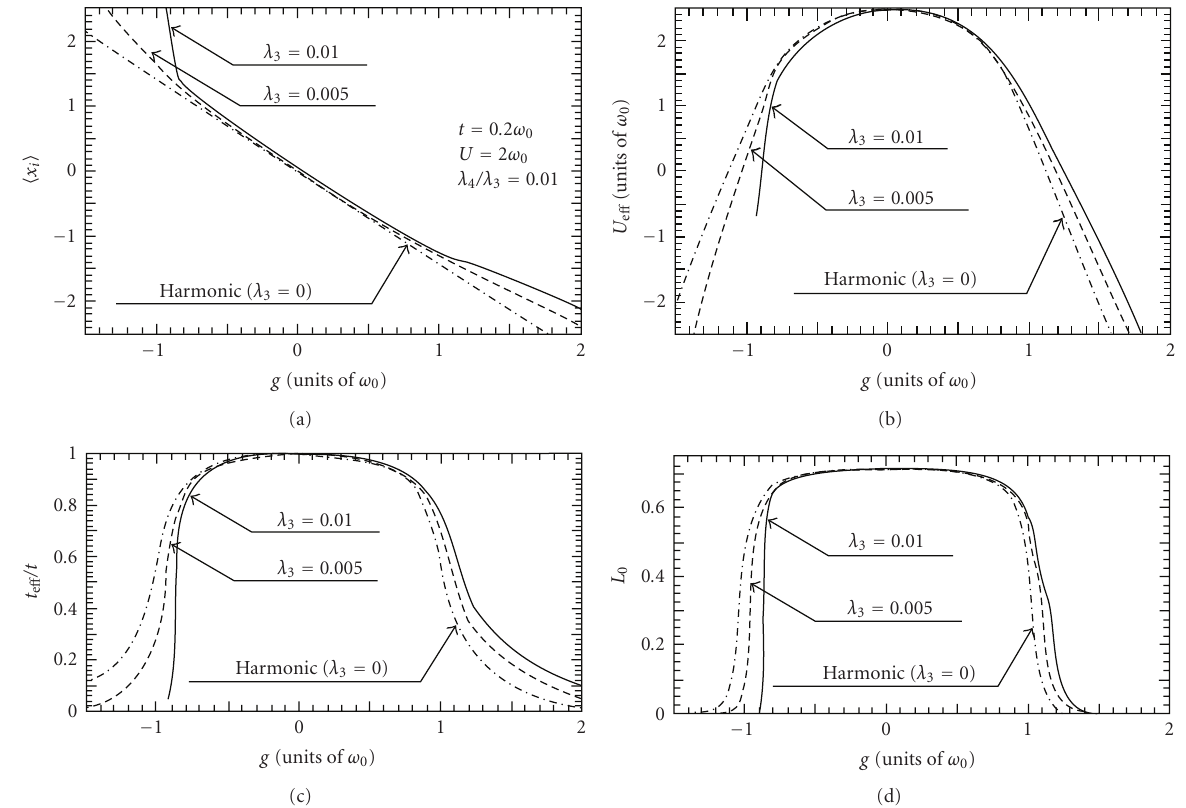
Figure 6: Plots of (a) the lattice displacement, (b) the e ff ective electron-electron interaction, (c) the renormalized hopping integral, and (d) the local spin moment as a function of g